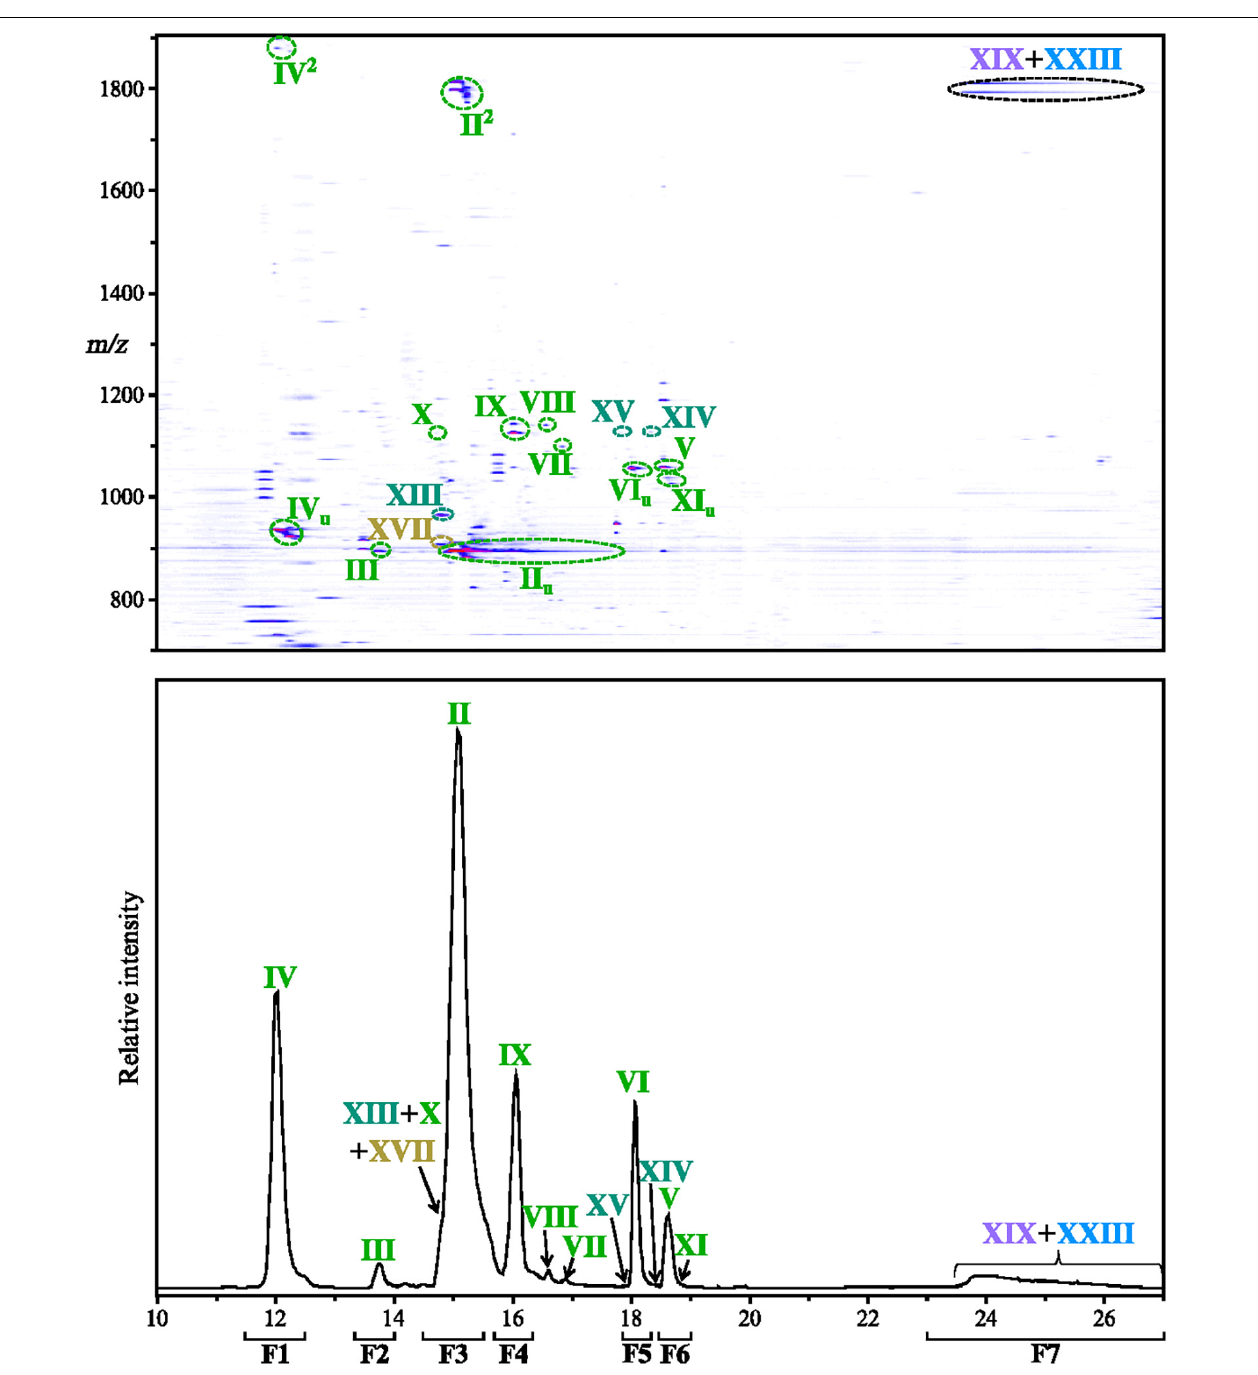
FIGURE 2 | Thermococcus barophilus exhibits a large diversity of intact polar lipids. Intact polar lipids were detected in positive and negative ion modes. As no additional intact polar lipid (IPL) could be identified in the negative ion mode, only the density map and chromatogram obtained in positive ion mode are displayed (zoom in the 10–27 min, m/z 700–1900 window). Compounds detected with unsaturations and/or diadducts are marked with u and 2 , respectively. The ultra-high performance liquid chromatography (UHPLC) chromatogram was drawn by extracting the following protonated ion masses with a mass deviation of ± 0.02 Da: 893.68, 894.70, 895.70, 909.72, 936.73, 965.78, 1038.69, 1056.77, 1057.75, 1098.78, 1124.83, 1125.82, 1126.85, 1127.83, 1139.81, 1786.36, and 1788.38. Refer to Figure 1 , Table 1 , and Supplementary Figures 1–9 for lipid structures and their respective molecular masses. F1–F7 delineate the time range corresponding to each fraction collected to confirm the structures of the identified lipids (refer to the Methods section).